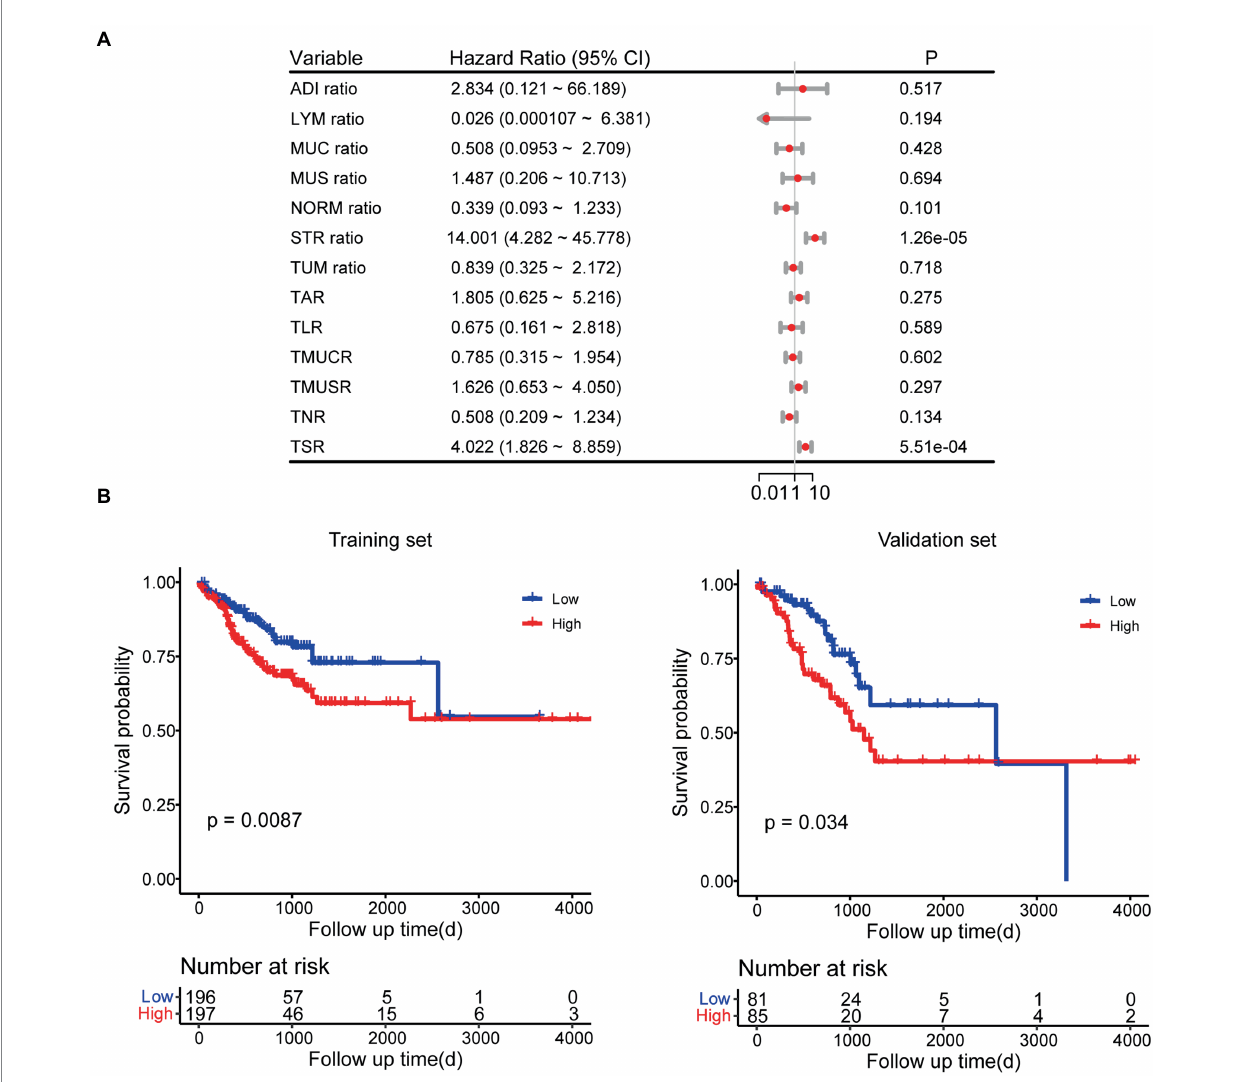
FIGURE 2 Survival analyses. (A) Univariate Cox regression analyses for TME features. (B) Kaplan–Meier survival analyses for TME signature.